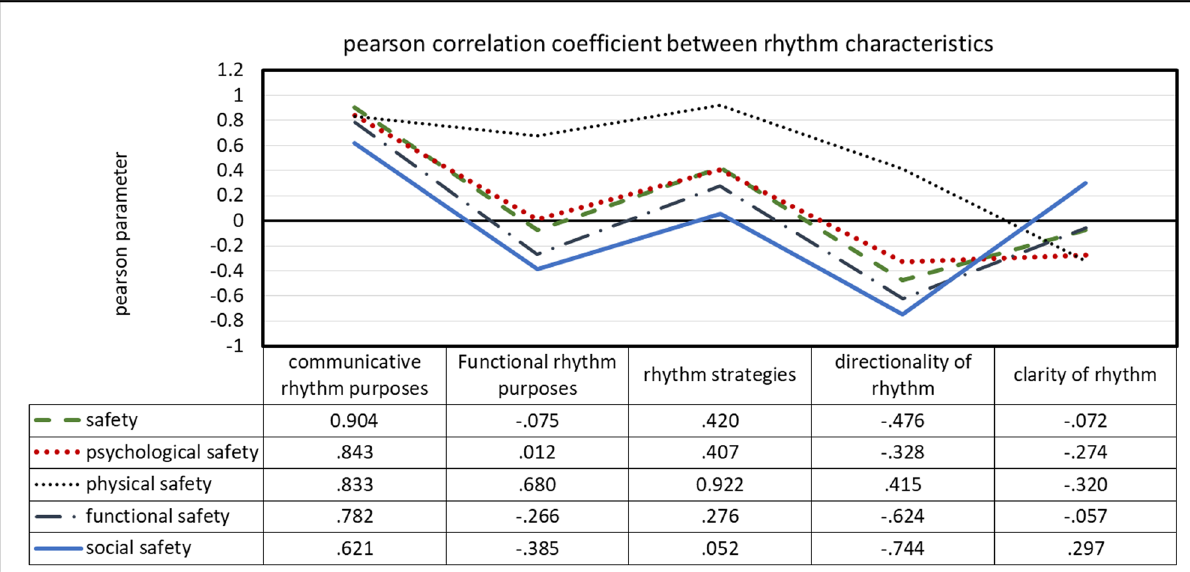
Figure 5: Shows linear regression of the relationship between safety and rhythm